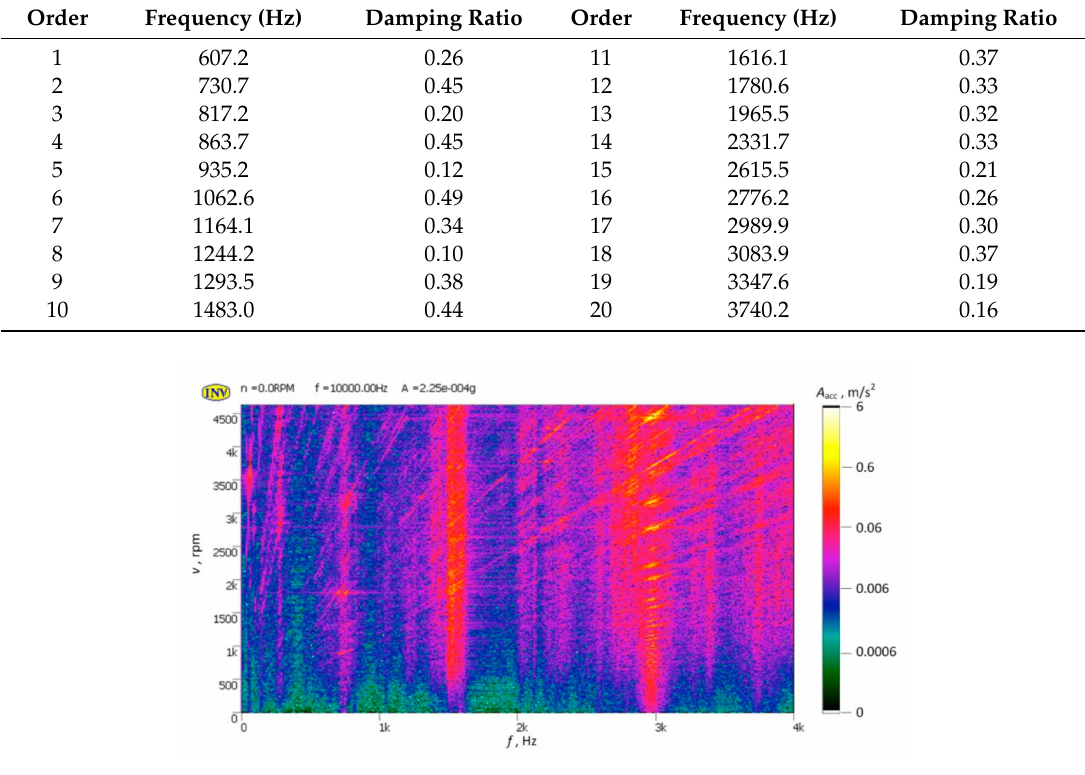
Figure 6. The vibration waterfall